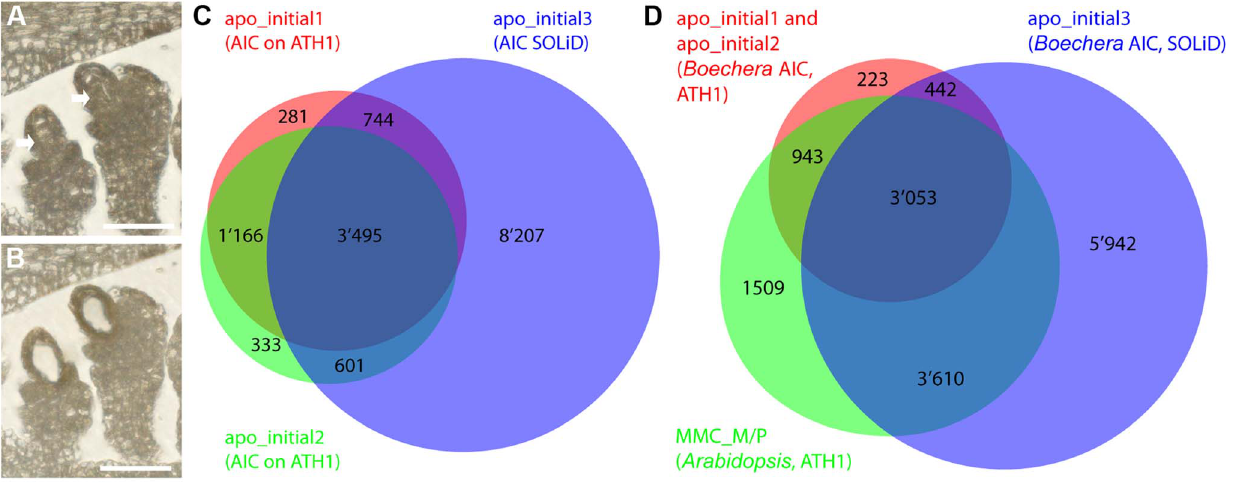
Figure 2. Laser-assisted microdissection (LAM) and transcriptome analysis to study the Boechera apomictic initial cell (AIC). (A, B) LAM of the AIC from a 6 m m dry section (scale bar=40 m m). (A) An ovule harbouring the AIC before LAM. Arrows point to the AICs. (B) The ovule after the AIC has been dissected and collected. (C, D) Venn diagrams showing the overlaps of prediction of expression (P calls; apo_initial1, apo_initial2, MMC_M/P) as determined with the Bg PANP algorithm or the At PANP algorithm described previously [12], and the genes with $ 5 read counts on Boechera homologues (apo_initial3) to the Arabidopsis genes as determined by mapping to the Boechera reference transcriptome.